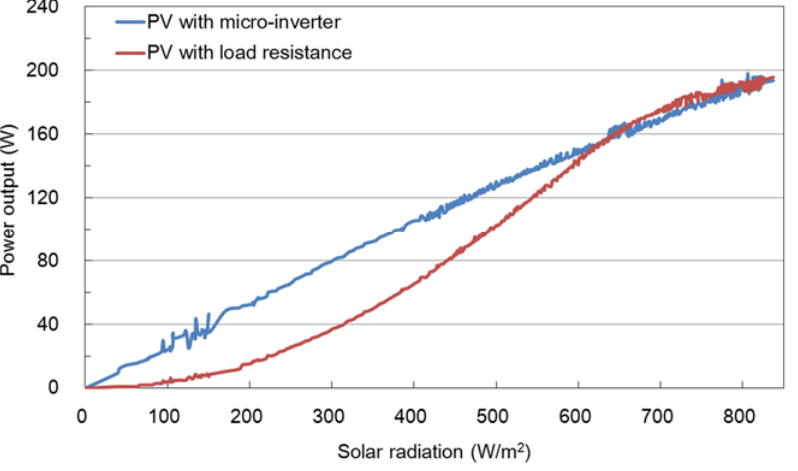
Figure 10. Daily thermal and electrical performance levels of the PVT system.